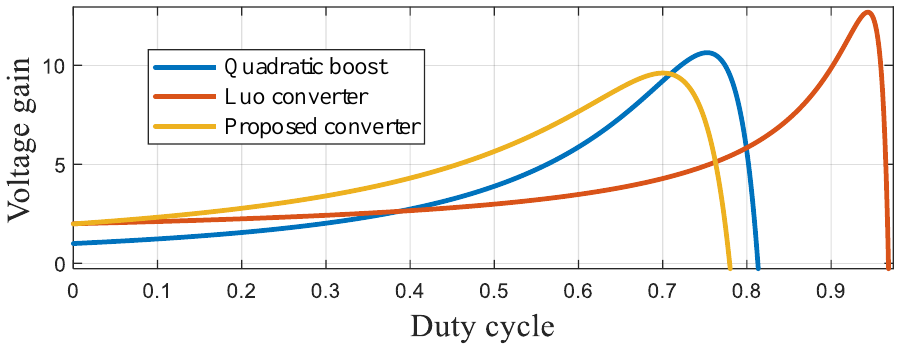
Figure 5. The comparison of the non-ideal voltage gain of the proposed converter with the quadratic boost and Luo